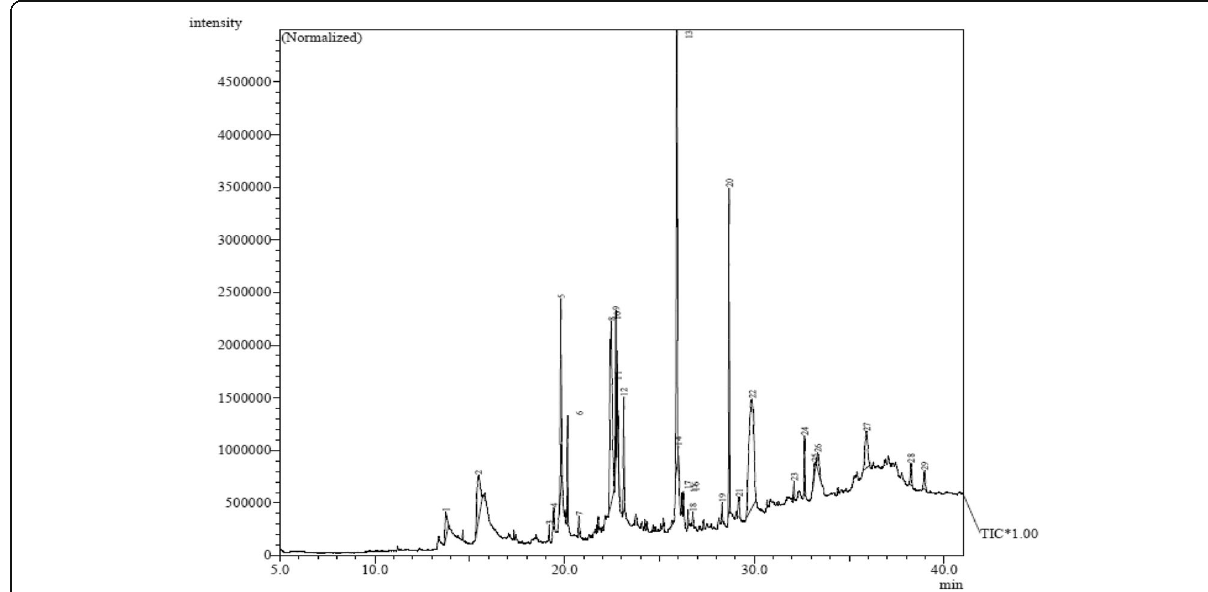
Fig. 5 GC-MS chromatogram for hexane fraction of S. latifolius